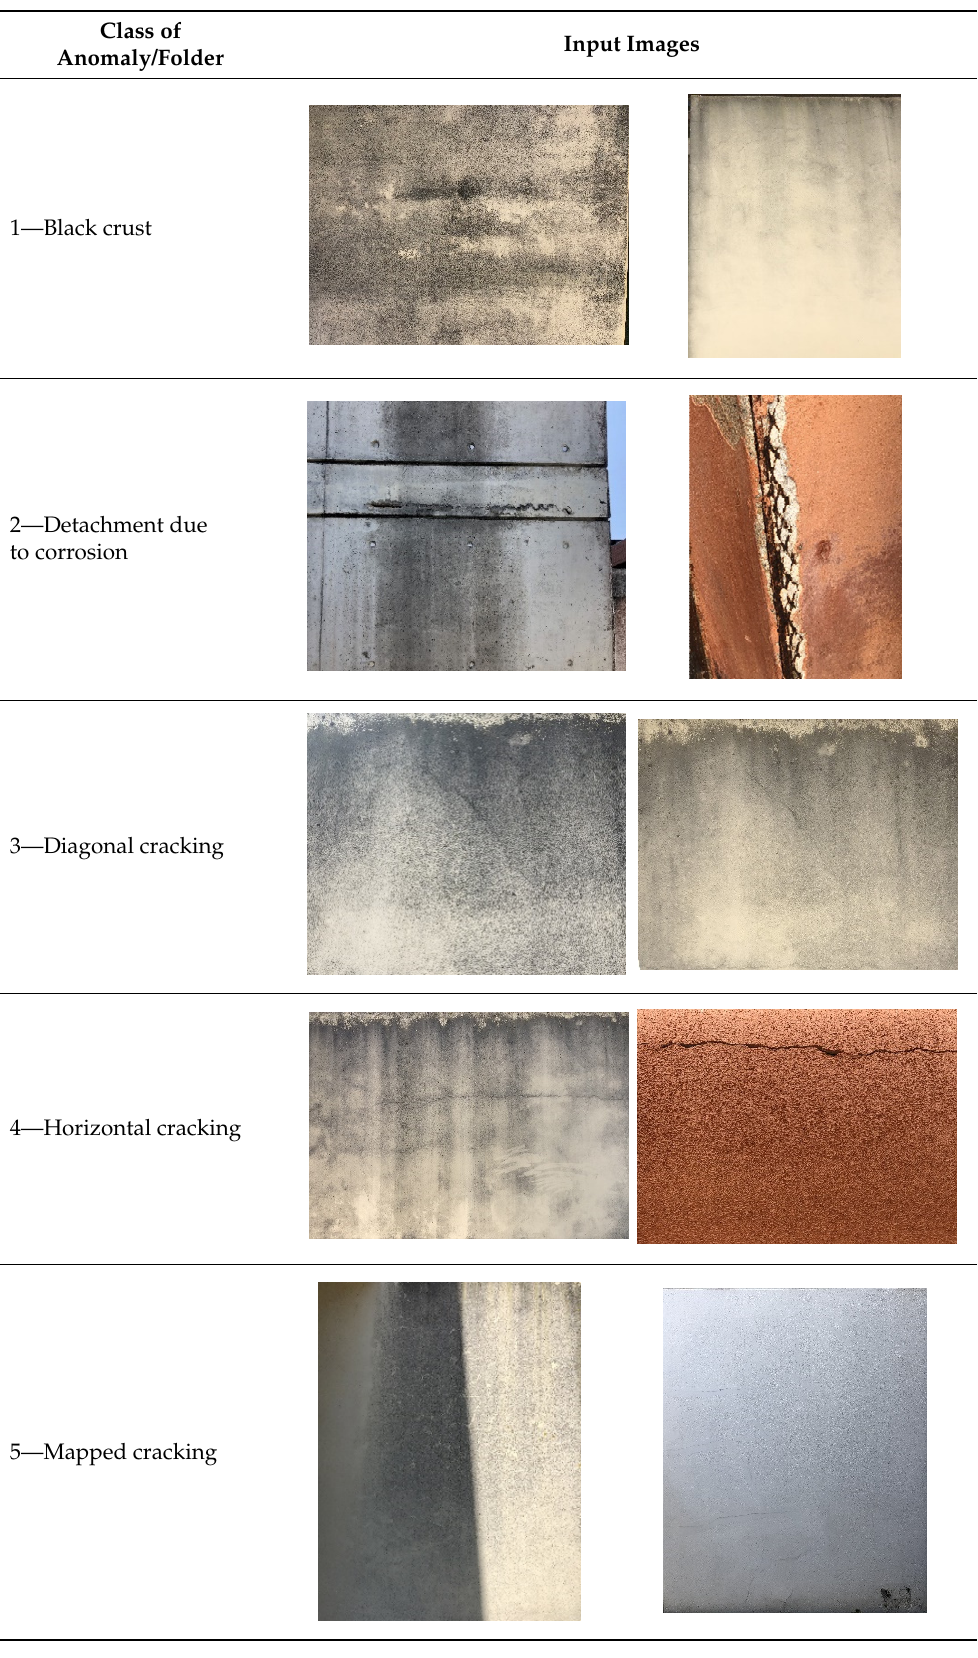
Table 1. Examples of inputs images considered in DL model